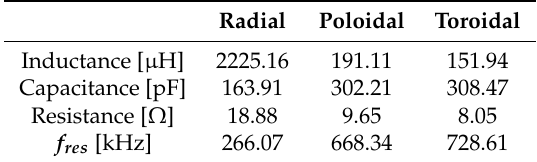
Table 2. RLC parameters and resonance frequency of the three prototype